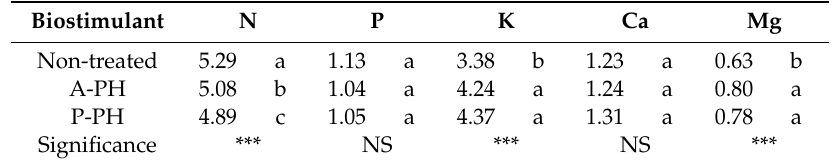
Table 2. E ff ect of di ff erent PHs on nitrogen (N), phosphorus (P), potassium (K), calcium (Ca), and magnesium (Mg) plant concentrations (mg g − 1 dw) of celery.